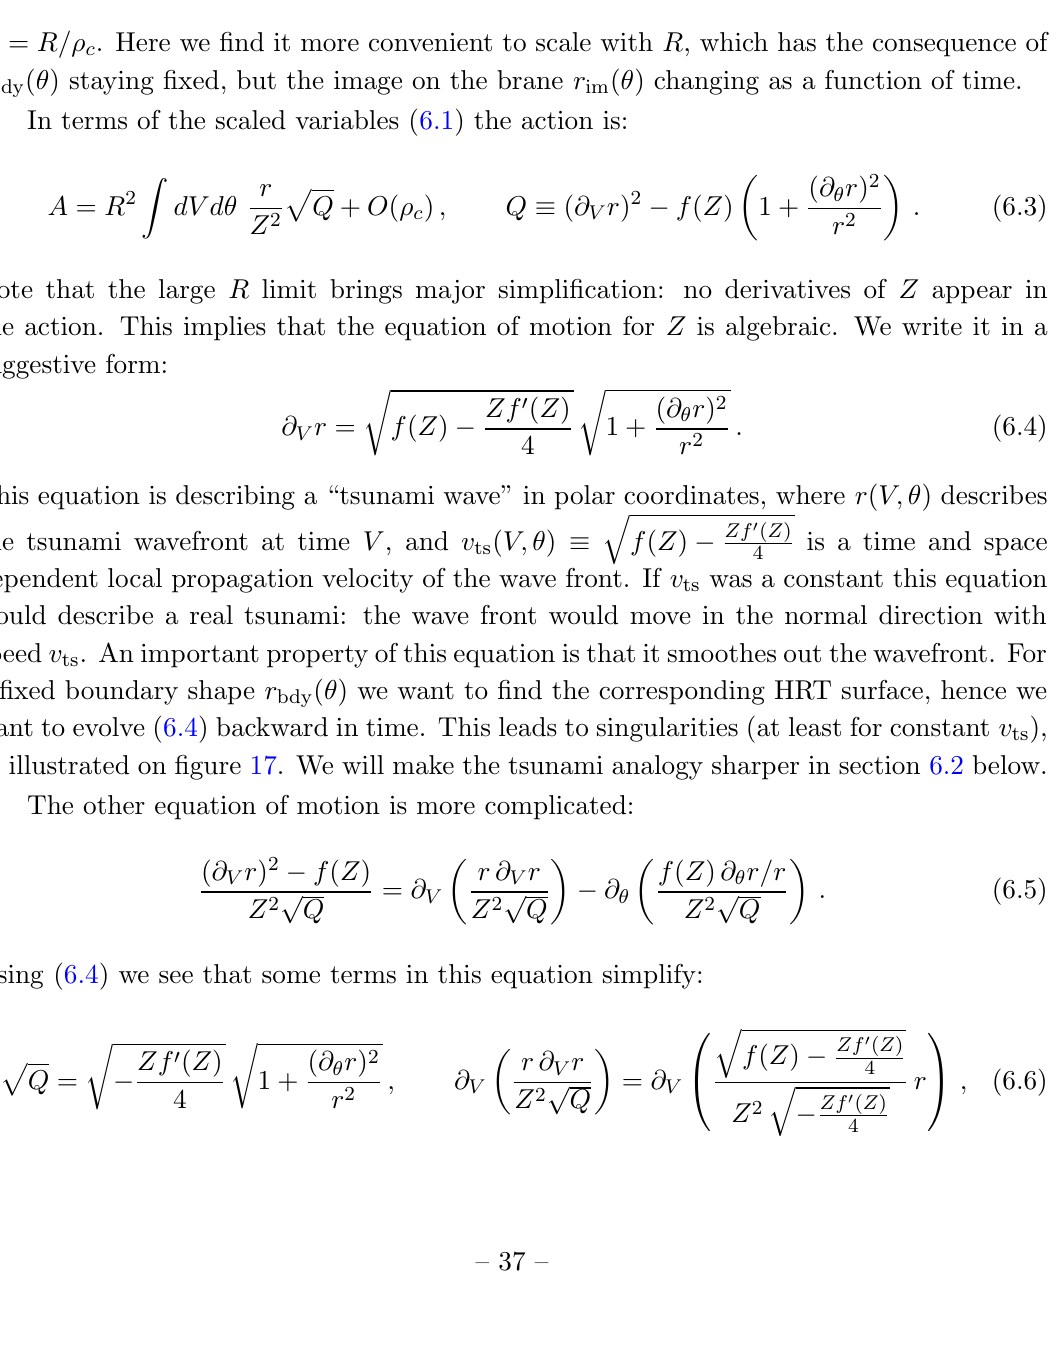
r (cid:3) = R=(cid:26) c . Here we (cid:12)nd it more convenient to scale with R , which has the consequence of r bdy ( (cid:18) ) staying (cid:12)xed, but the image on the brane r im ( (cid:18) ) changing as a function of